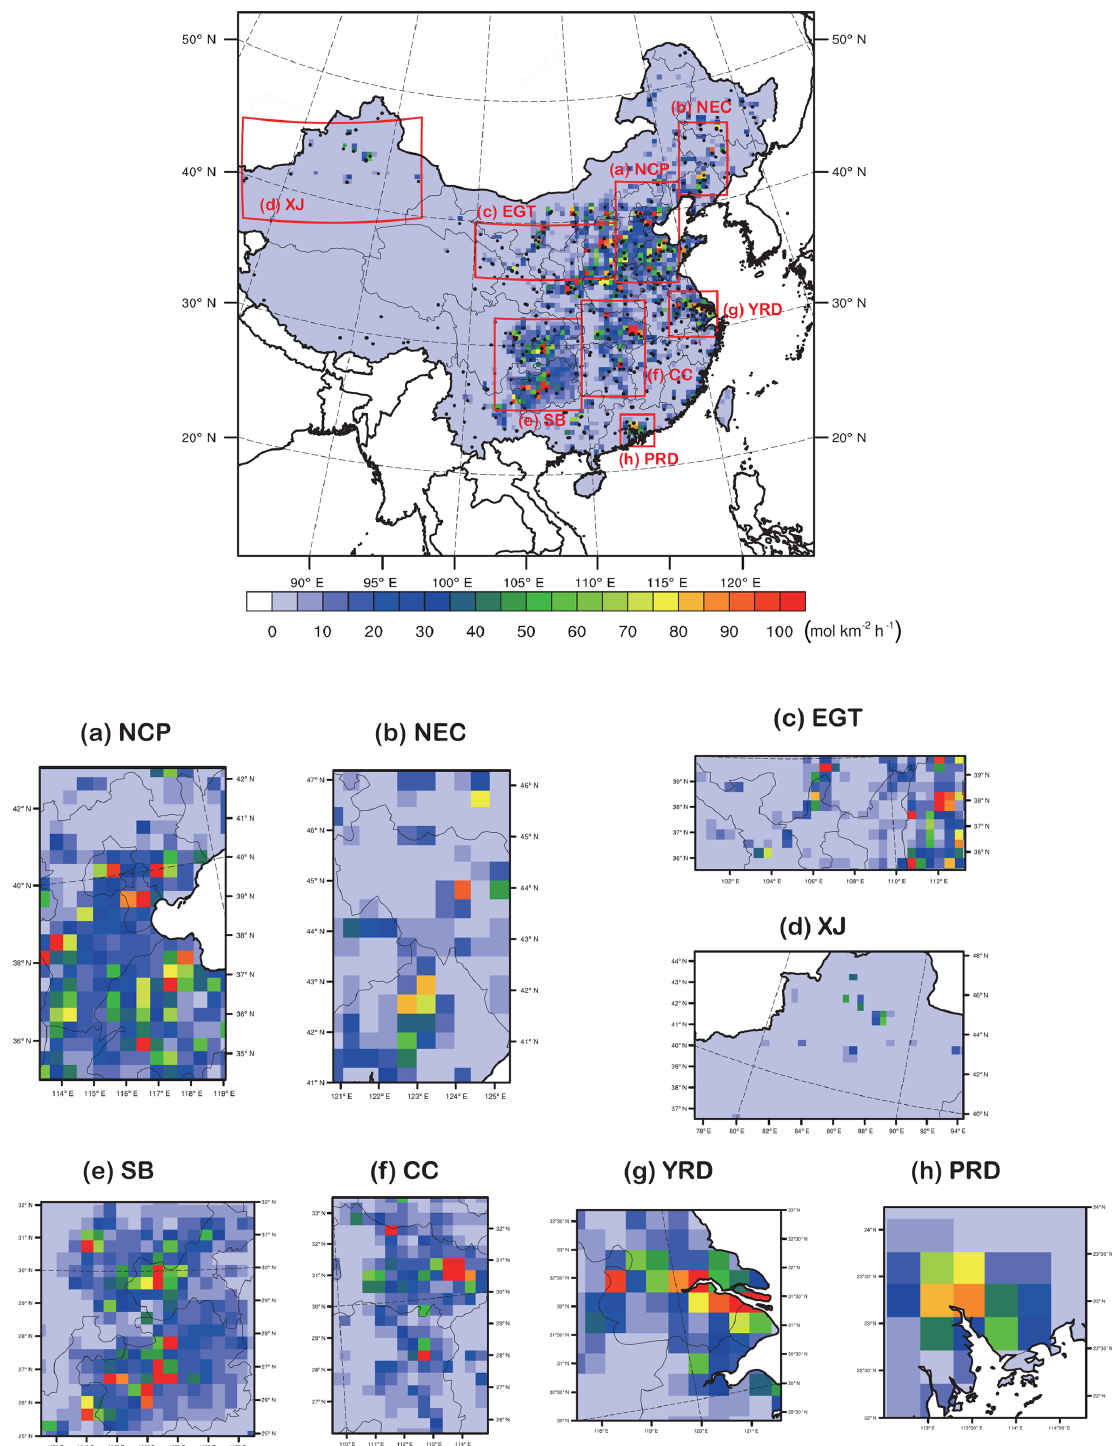
Figure 2. Spatial distribution of the a priori SO 2 emissions used in this study. Regions defined in the red rectangles are (a) NCP (the North China Plain), (b) NEC (northeastern China), (c) EGT (the Energy Golden Triangle), (d) XJ (Xinjiang), (e) SB (the Sichuan Basin), (f) CC (central China), (g) YRD (the Yangtze River Delta), and (h) PRD (the Pearl River Delta). The color coding of the regional plots relates to the color bar of the national plot. (Units are in molkm − 2 h − 1